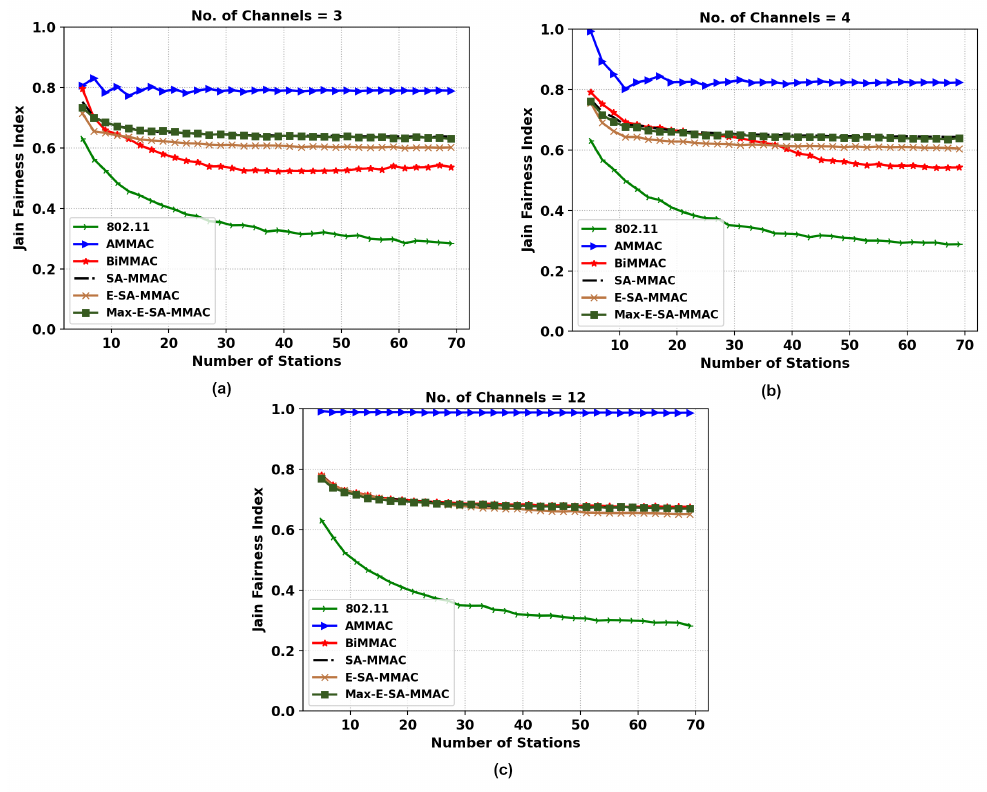
Figure 7. JFI comparison of the two MMAC protocols, E-SA-MMAC, and Max-E-SA-MMAC, versus others; ( a ) 3, ( b ) 4, and ( c ) 12